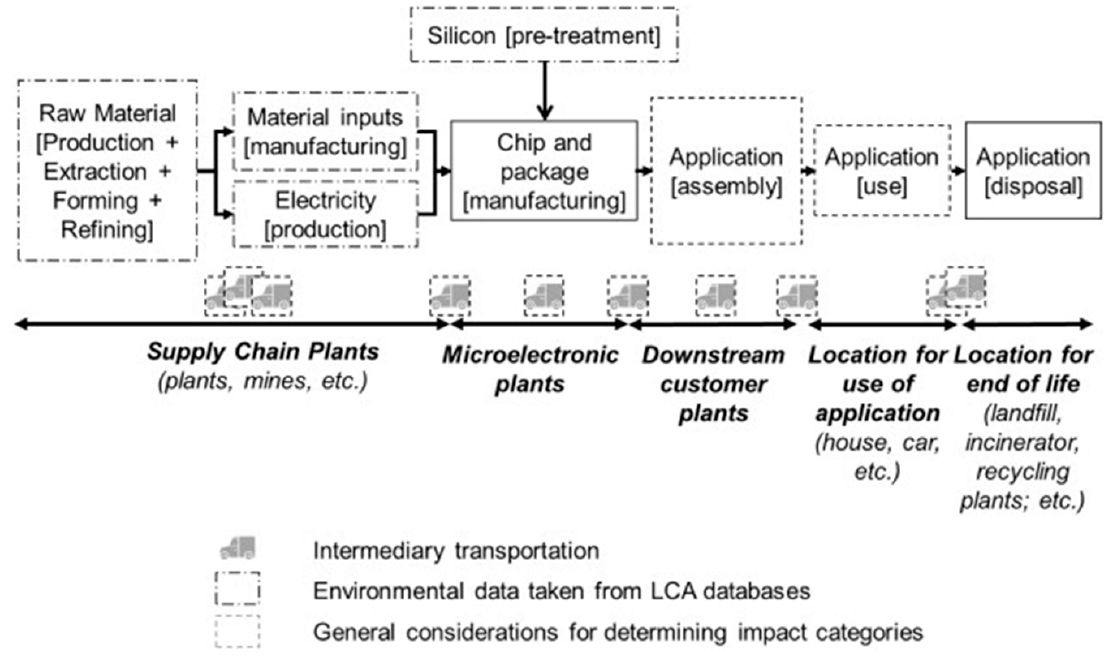
Figure 5. The general phases in a component life cycle [46]. Reprinted from Journal of Cleaner Production, Volume 86, Aurélie Villard, Alan Lelah, Daniel Brissaud, Drawing a chip environmental profile: environmental indicators for the semiconductor industry, Pages 98–109., Copyright (2015), with permission from Elsevier [46].